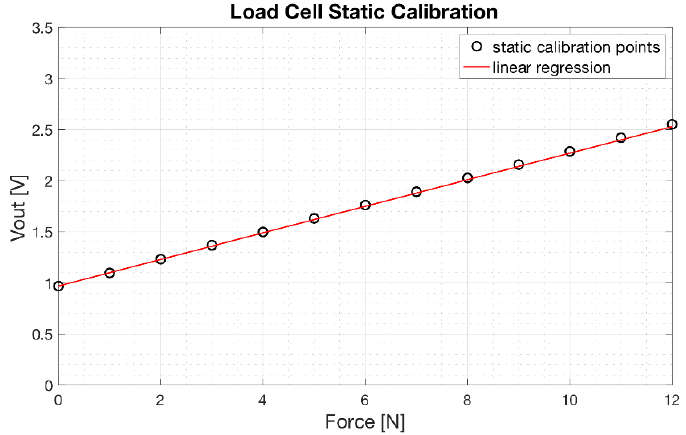
Figure 10. Load cell static calibration: scatter plot of the experimental data (o) and linear regression (continuous red line).